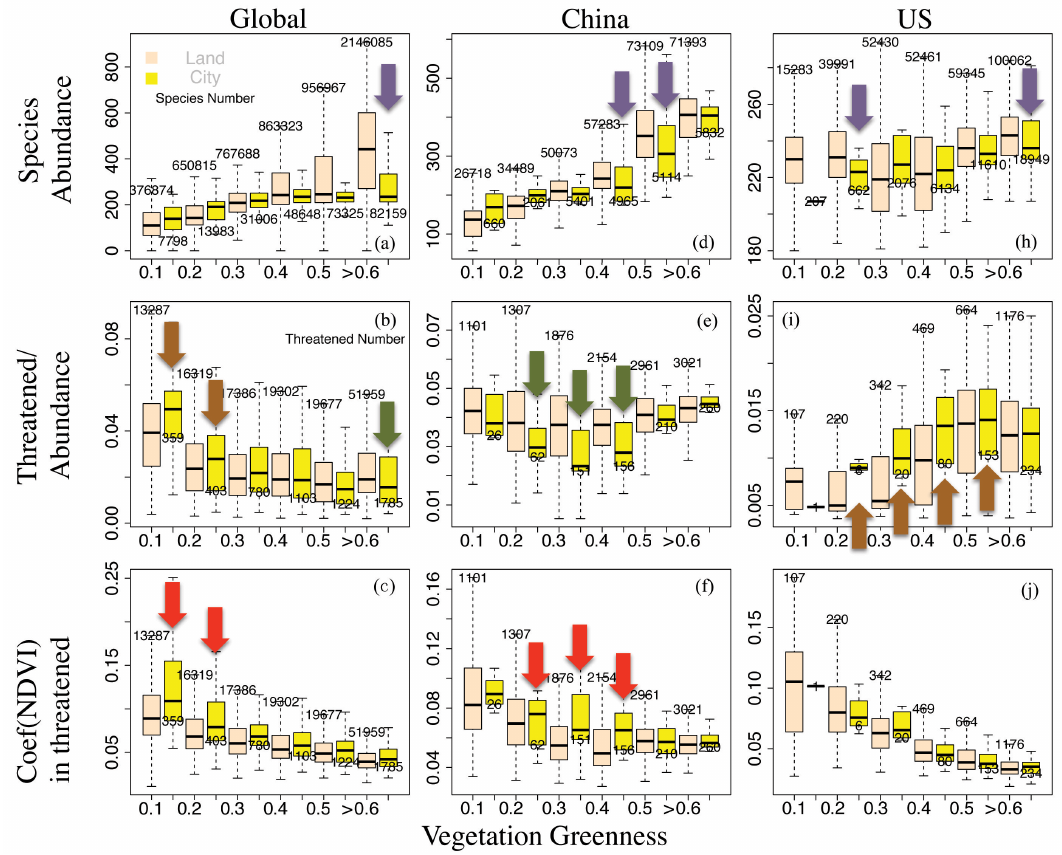
Figure 4. Land-city comparison for across the ( a – c ) Globe, ( d – f ) China and ( h – j ) America: Statistics of the species abundance versus vegetation greenness (upper row), the threatened species indicator (threatened species number / species abundance) versus vegetation greenness (middle row), and the coe ffi cients of annual Normalized Di ff erence Vegetation Index (NDVI) variability versus vegetation greenness (bottom row). Arrows show obvious land and city contrast, and green and brown arrows identify green / brown cities with a positive / negative e ff ect on biodiversity, as quantified by lower / higher threatened species indicator.